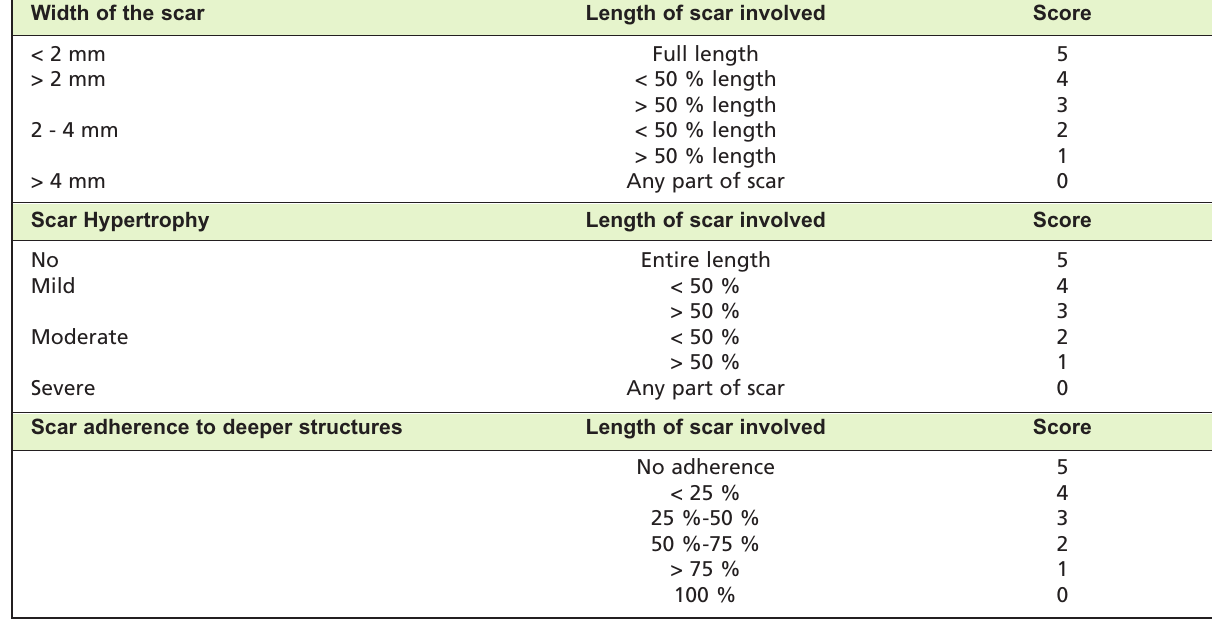
Criteria for assessment of the scar at final follow-up Table I: